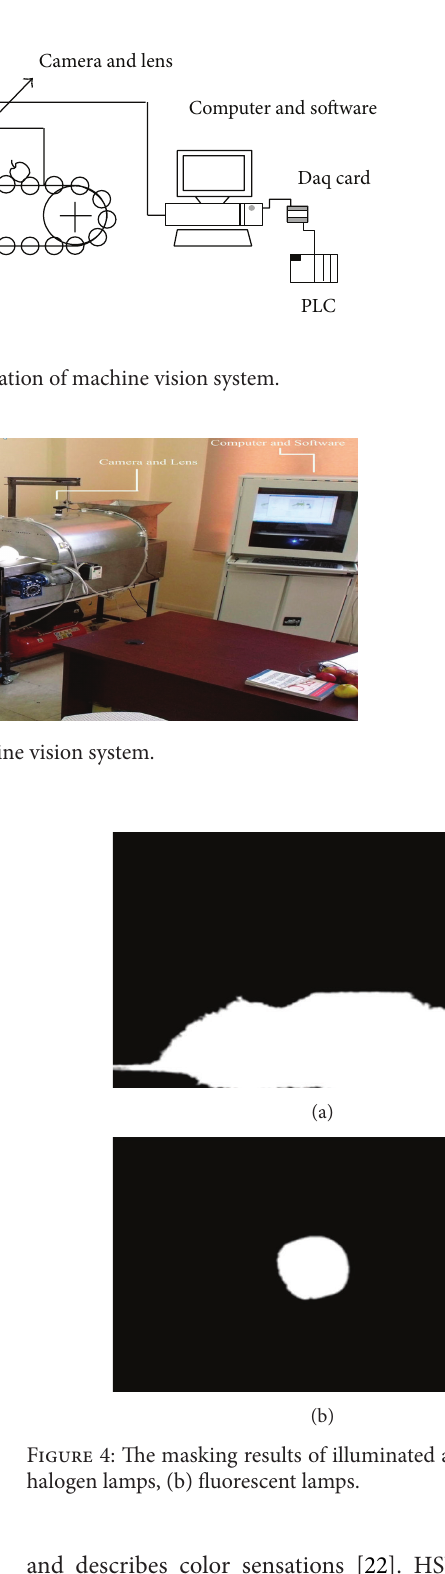
and describes color sensations [22]. HSV separates color into three components: hue, saturation, and value. 𝐻 (hue) green, and blue. 𝑉 (value) represents the brightness of a